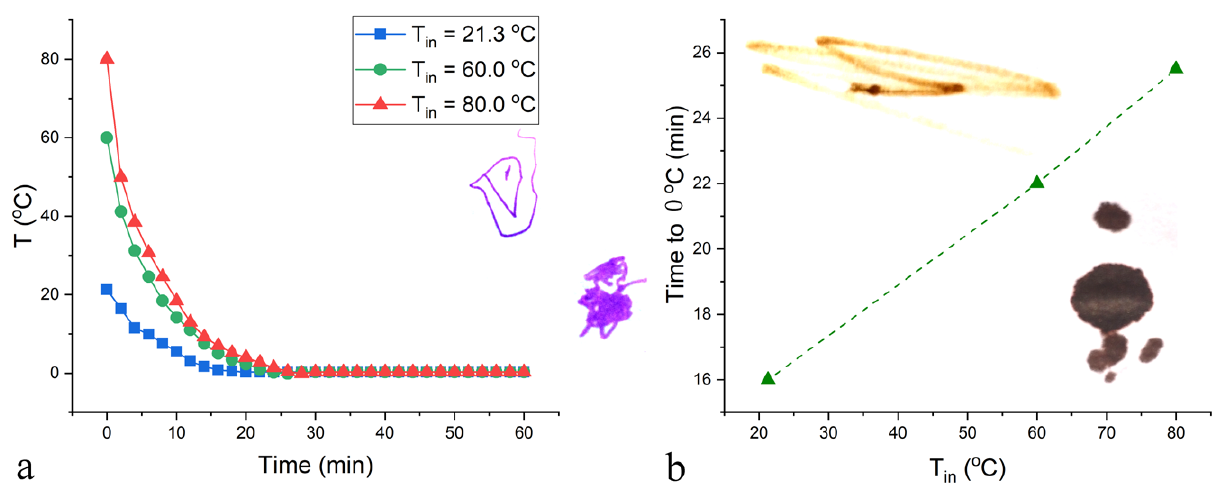
Figure 1. Temperature change over time for DI water with different starting temperatures, including 25 and 60 and 80 o C, when incubated at -18 o C (a). Time it takes for the liquid phase to reach 0 o C depending on the initial temperature of DI water incubated at -18 o C